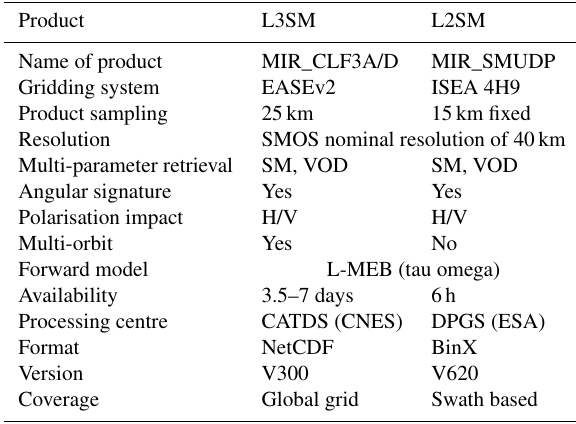
Table 4. Main characteristics of the SMOS Level 3 and Level 2 SM